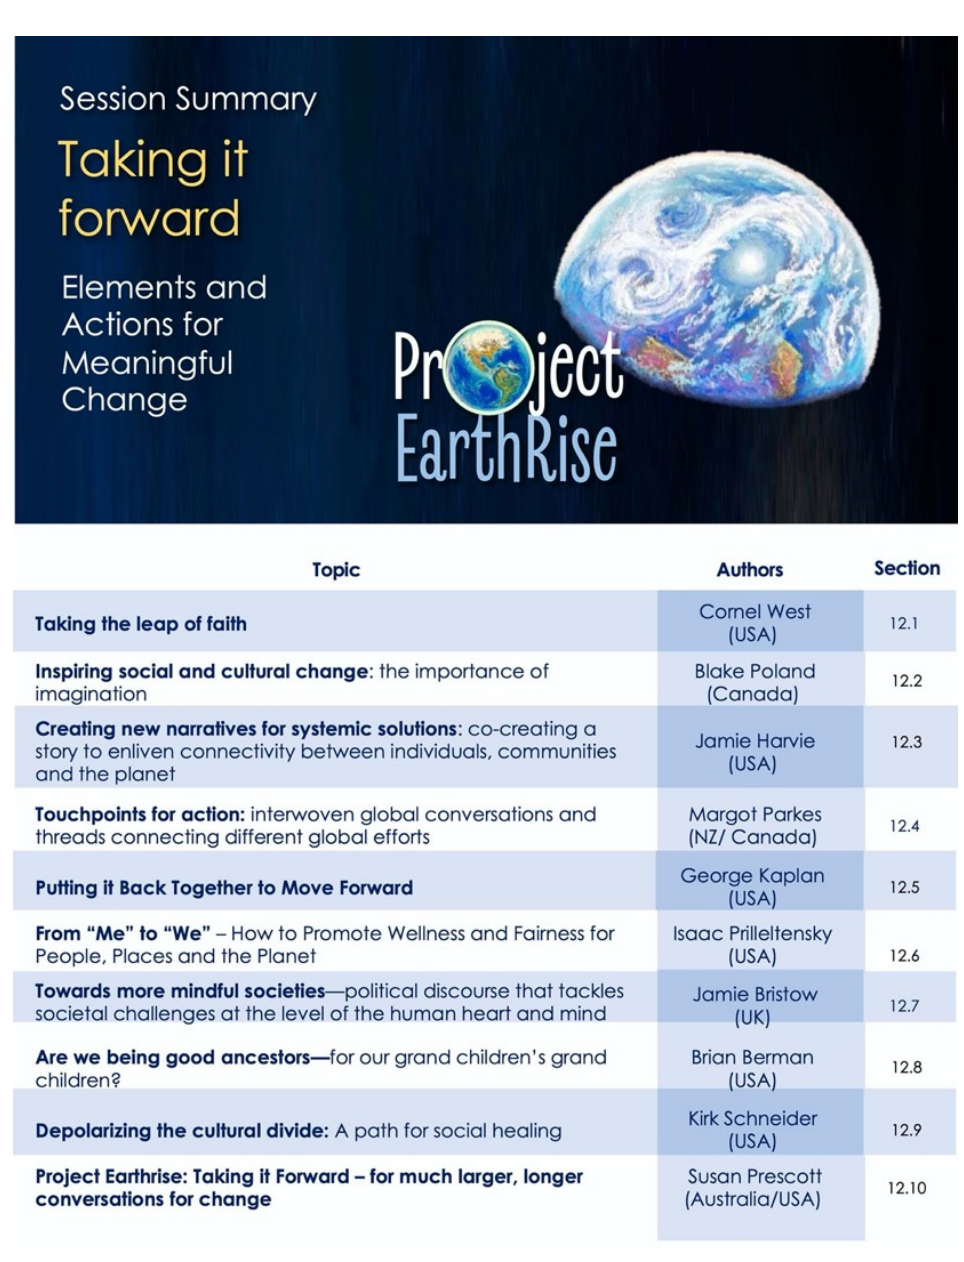
Figure 11. Elements and Actions for Meaningful Change: Overview of topics and speakers in the session considering the “next steps” for Project Earthrise .